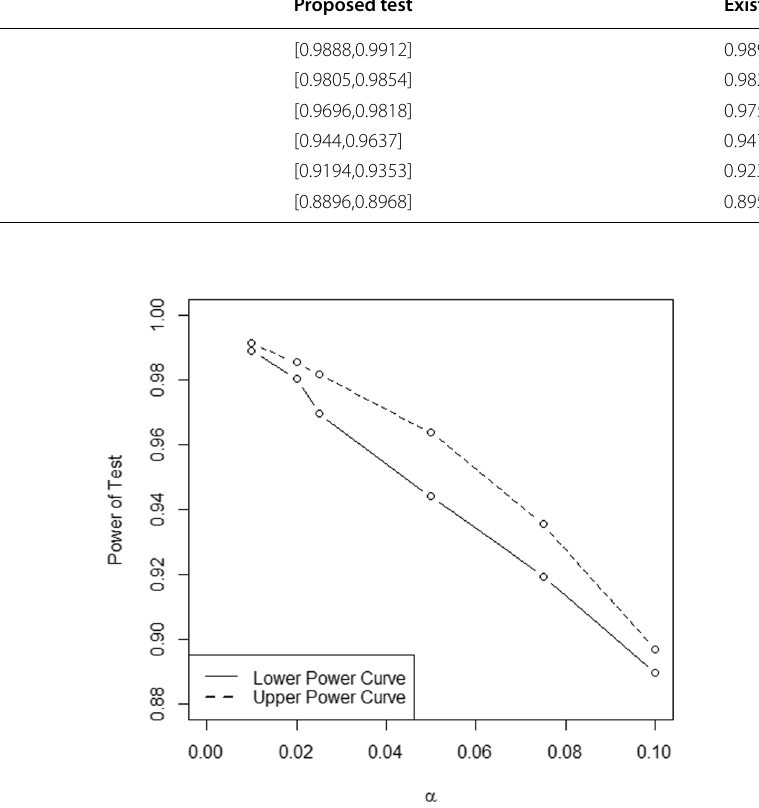
Table 5 Power of the test of two tests α Proposed test